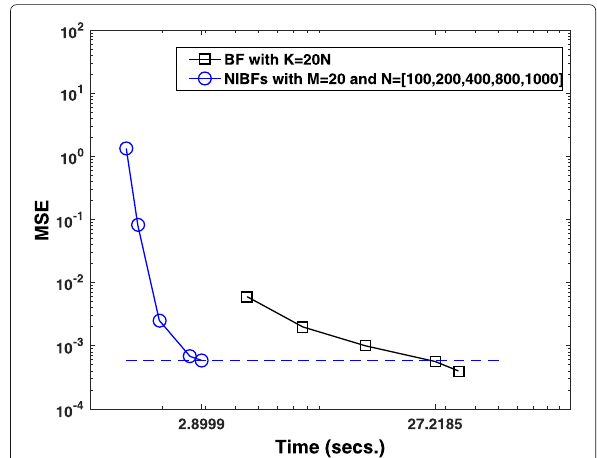
Fig. 1 Empirical mean of the MSE for the centralised BF, with K = MN particles, and the ensemble of NIBFs, with M = 20 constant and N = 100,200,400,800,1000. All curves have been obtained from a set of 100 independent simulation trials. Note that the centralised BF is run with K = 20 N particles, where N takes values in the same way as for the parallel algorithm